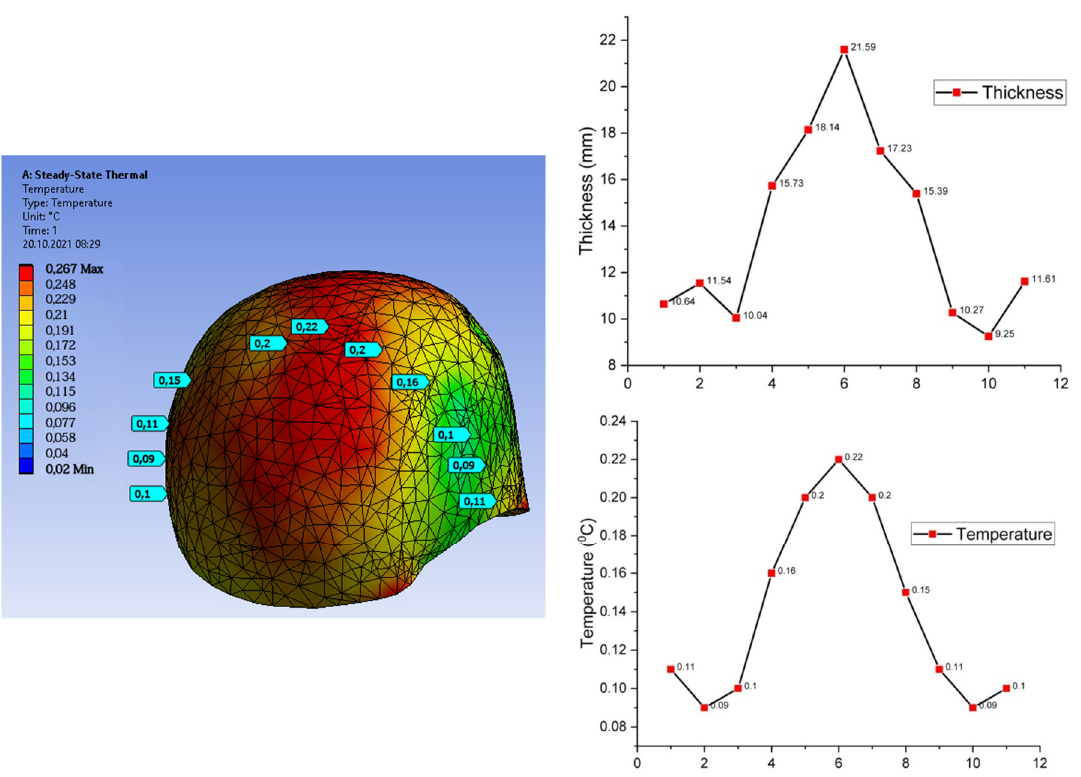
Figure 14. Temperature and thickness values along the temporal and parietal bones (i.e., first curve).